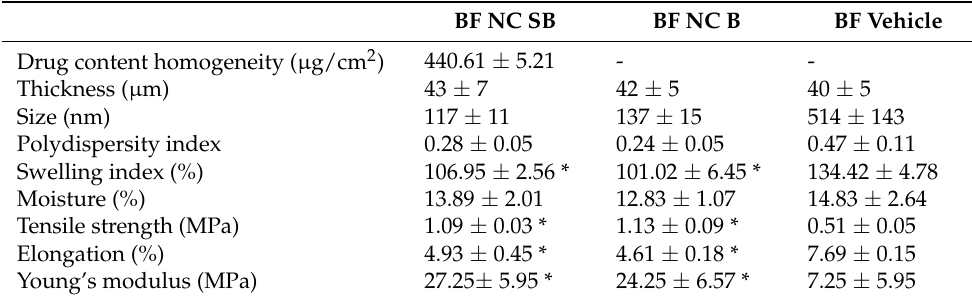
Table 1. Results of bilayer films characterization.